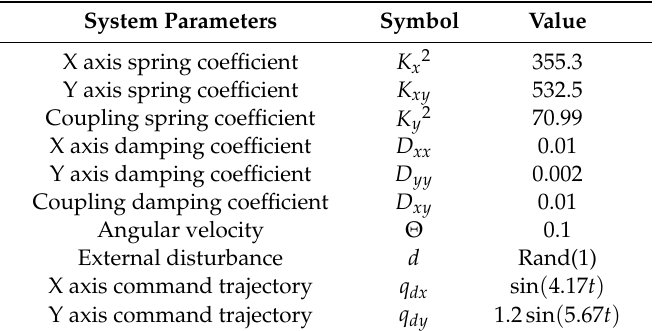
Table 1. Nominal Parameters of the Z-axis gyroscope.